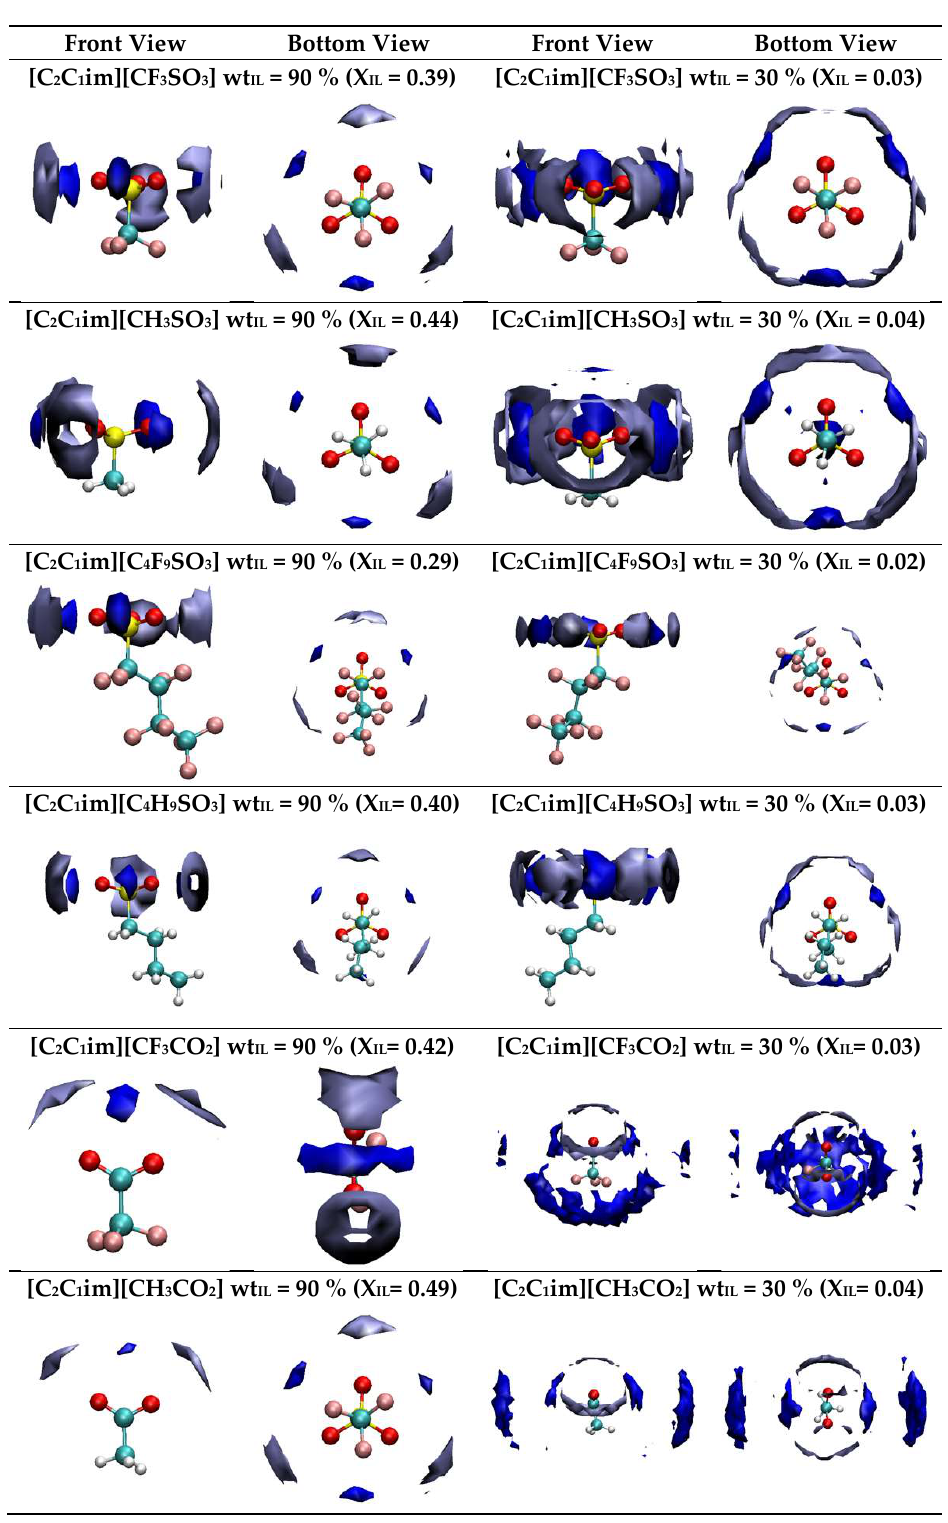
Figure 13. Selected spatial distribution functions around the [C n F 2 n +1 SO 3 ] − , [C n H 2 n +1 SO 3 ] − , [CF 3 CO 2 ] − , and [CH 3 CO 2 ] − anions in aqueous mixtures of [C 2 C 1 im][C n F 2 n +1 SO 3 ], [C 2 C 1 im][C n H 2 n +1 SO 3 ], [C 2 C 1 im][CF 3 CO 2 ], and [C 2 C 1 im][CH 3 CO 2 ] at 300 K. The blue color represents H atom of cations attached to the carbon between nitrogen atoms of the imidazolium ring and light blue depicts water O atom. The isosurface value is 70% of the maximum number density.